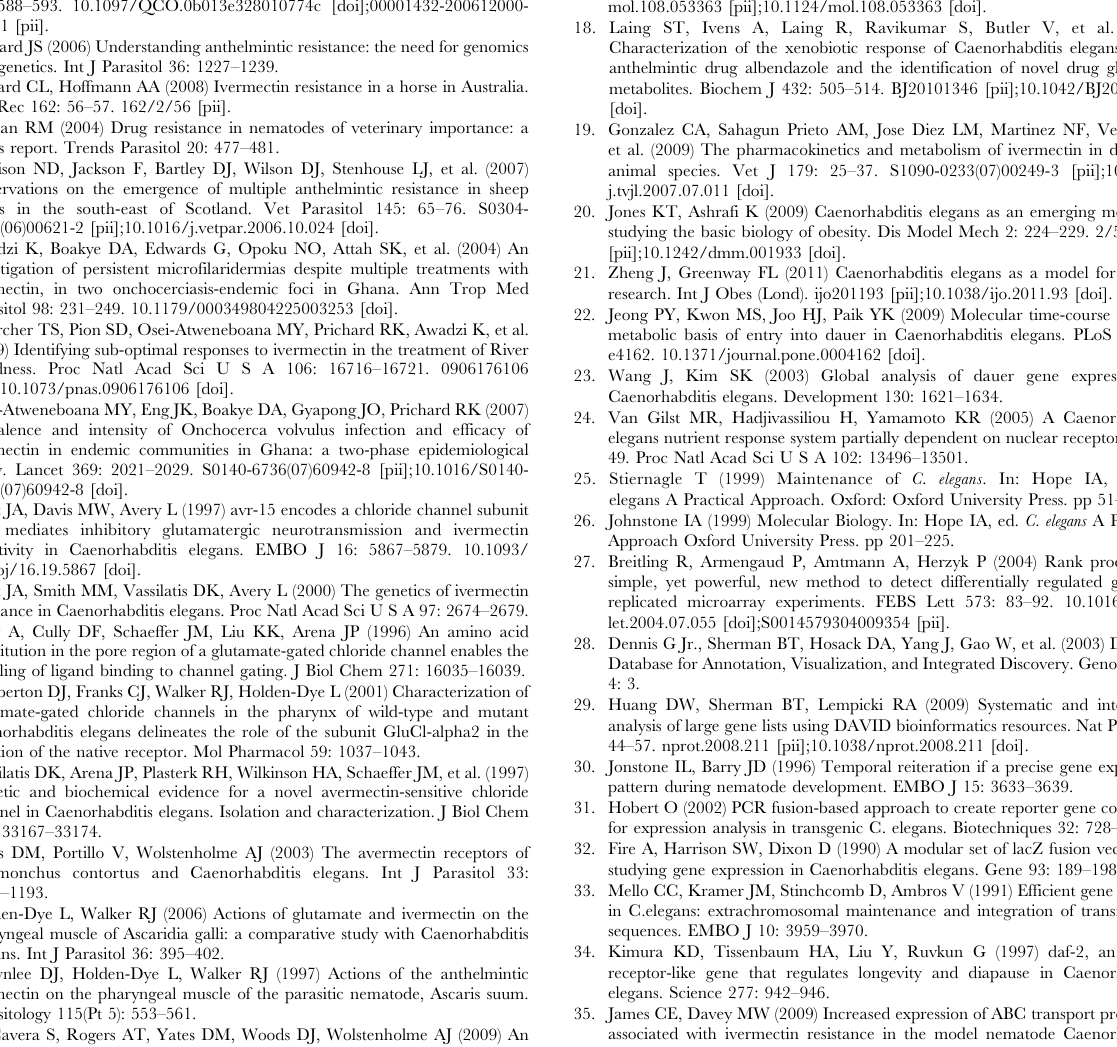
Table S4 Ontology terms associated with down-regu- lated genes in response to exposure of DA1316 to 1 m g/